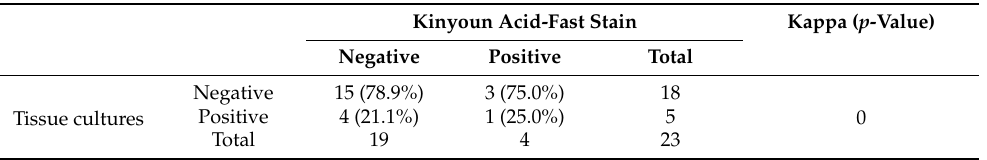
Table 3. Concordance in positivity of results between Kinyoun acid-fast stain performed on lung tissue sections and the corresponding tissue cultures (23 patients).